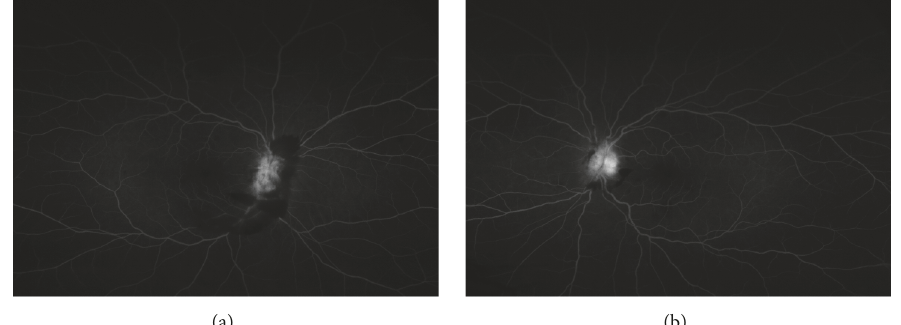
Figure 3: Fluorescein angiography (FA) taken at six minutes of (a) right and (b) left eye showing disc hyperfluorescence without disc leakage and surrounding peripapillary hemorrhages.